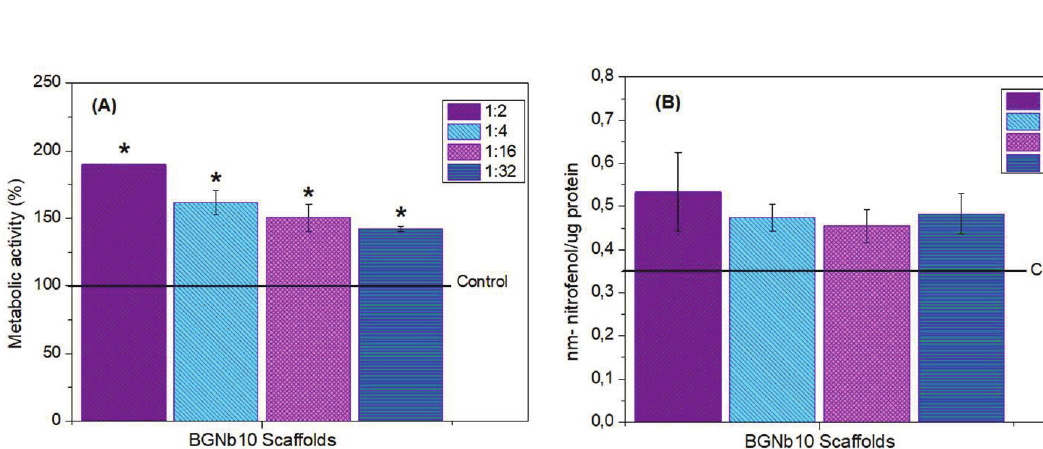
Table 1. Porosity, compressive strength and relative density (ρ/ρ Sample